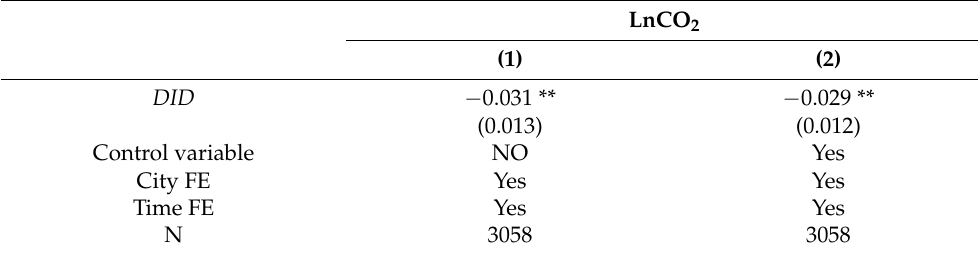
Table 5. Impact of LCCP on carbon emission (PSM-DID).